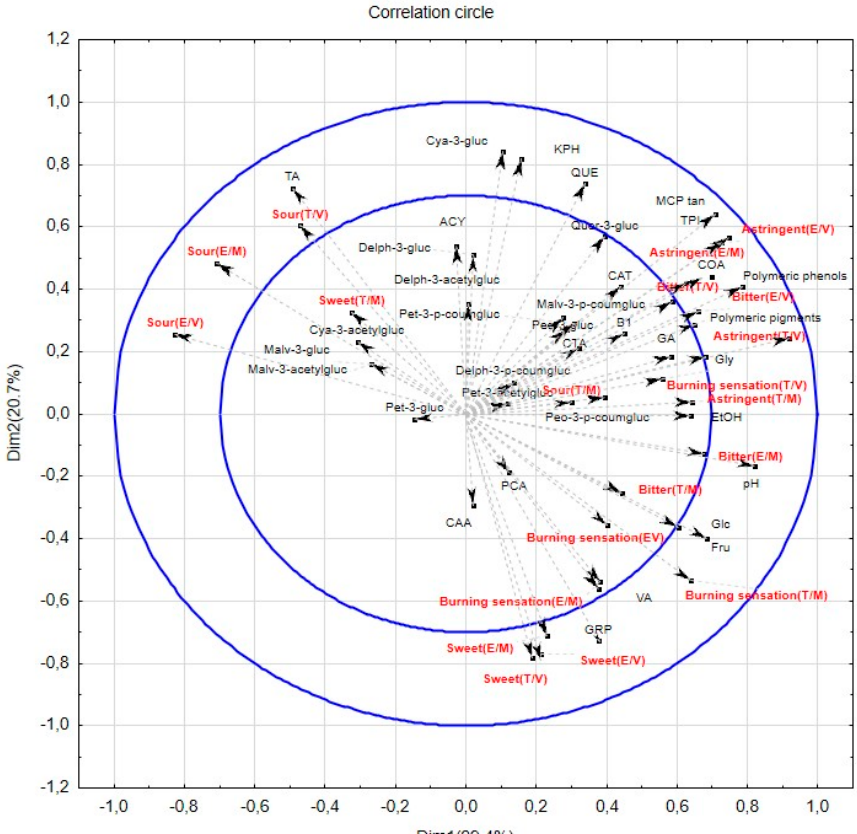
Figure 2. Correlation circle of multifactor analysis performed on the sensory variables given by the two panels in the two tasting modalities and the physicochemical composition of the wine samples. The sensory variables were sweet, sour, bitter, astringent, and burning sensation. The physicochemical variables were volatile acidity (VA), total acid (TA), pH, ethanol concentration (EtOH), MCP tannin levels (MCP tan), anthocyanins (ANT), total polyphenol index (TPI), glucose (Glc), fructose (Fru), glycerol (GLY), gallic acid (GA), grape reaction product (GRP), delphinidin-3-glucoside, caftaric acid (CTA), cyanidin-3-glucoside, (+)-catechin (CAT), procyanidin B1 (B1), petunidin-3-gluc, caffeic acid (CAA), coutaric acid (COA), peonidin-3-glucoside, malvidin-3-glucoside, delphinidin-3-acetylglucoside, cyanidin-3-acetylglucoside, p-coumaric acid (pCA), petunidin-3-acetylglucoside, quercetin-3-glucoside, malvidin-3-acetylglucoside, delphinidin-3-coumarylglucoside, malvidin-3-coumarylglucoside, polymeric pigments, quercetin (QUE), and kaempferol (KPH).